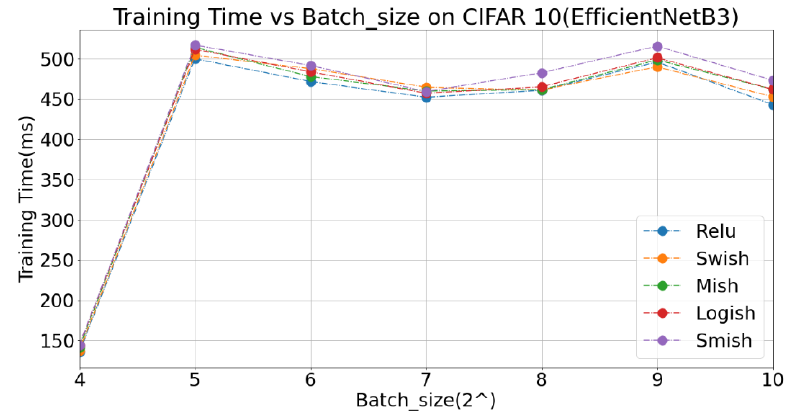
Figure 5. Training time vs. batch_size on CIFAR10.